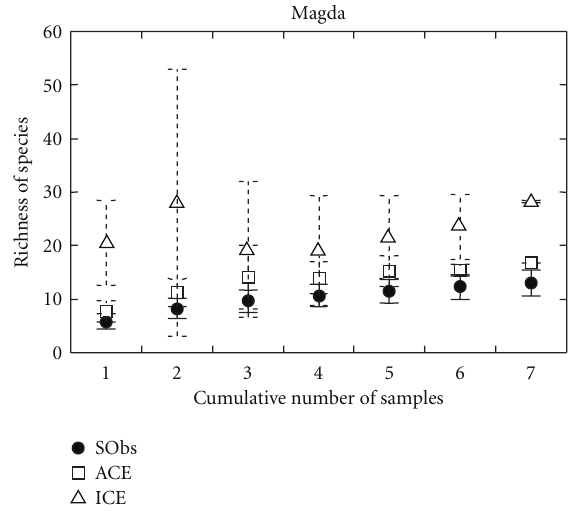
Figure 2: Richness of species observed and estimated using ACE (Abundance-based Coverage Estimator) and ICE (Incidence-based Coverage Estimator) indexes to the area of